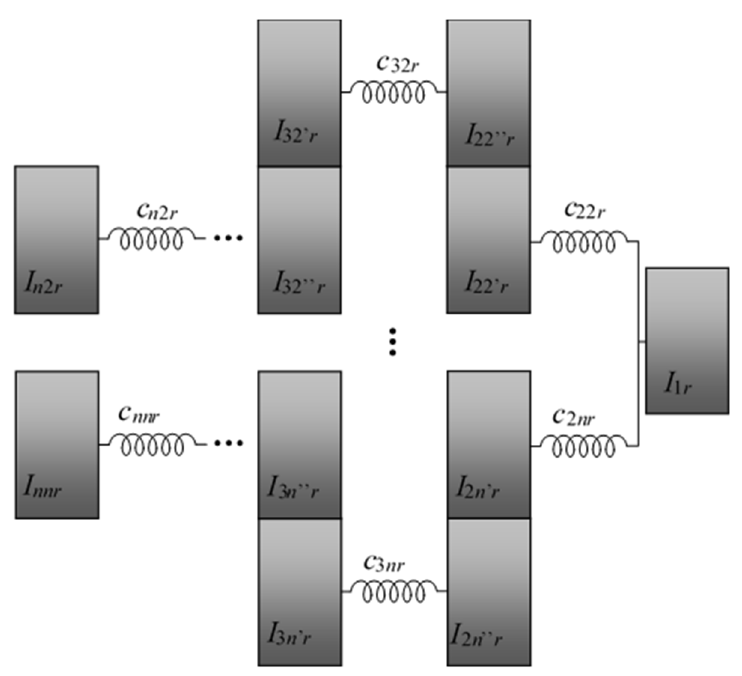
Figure 7. Model of the drive system including all the